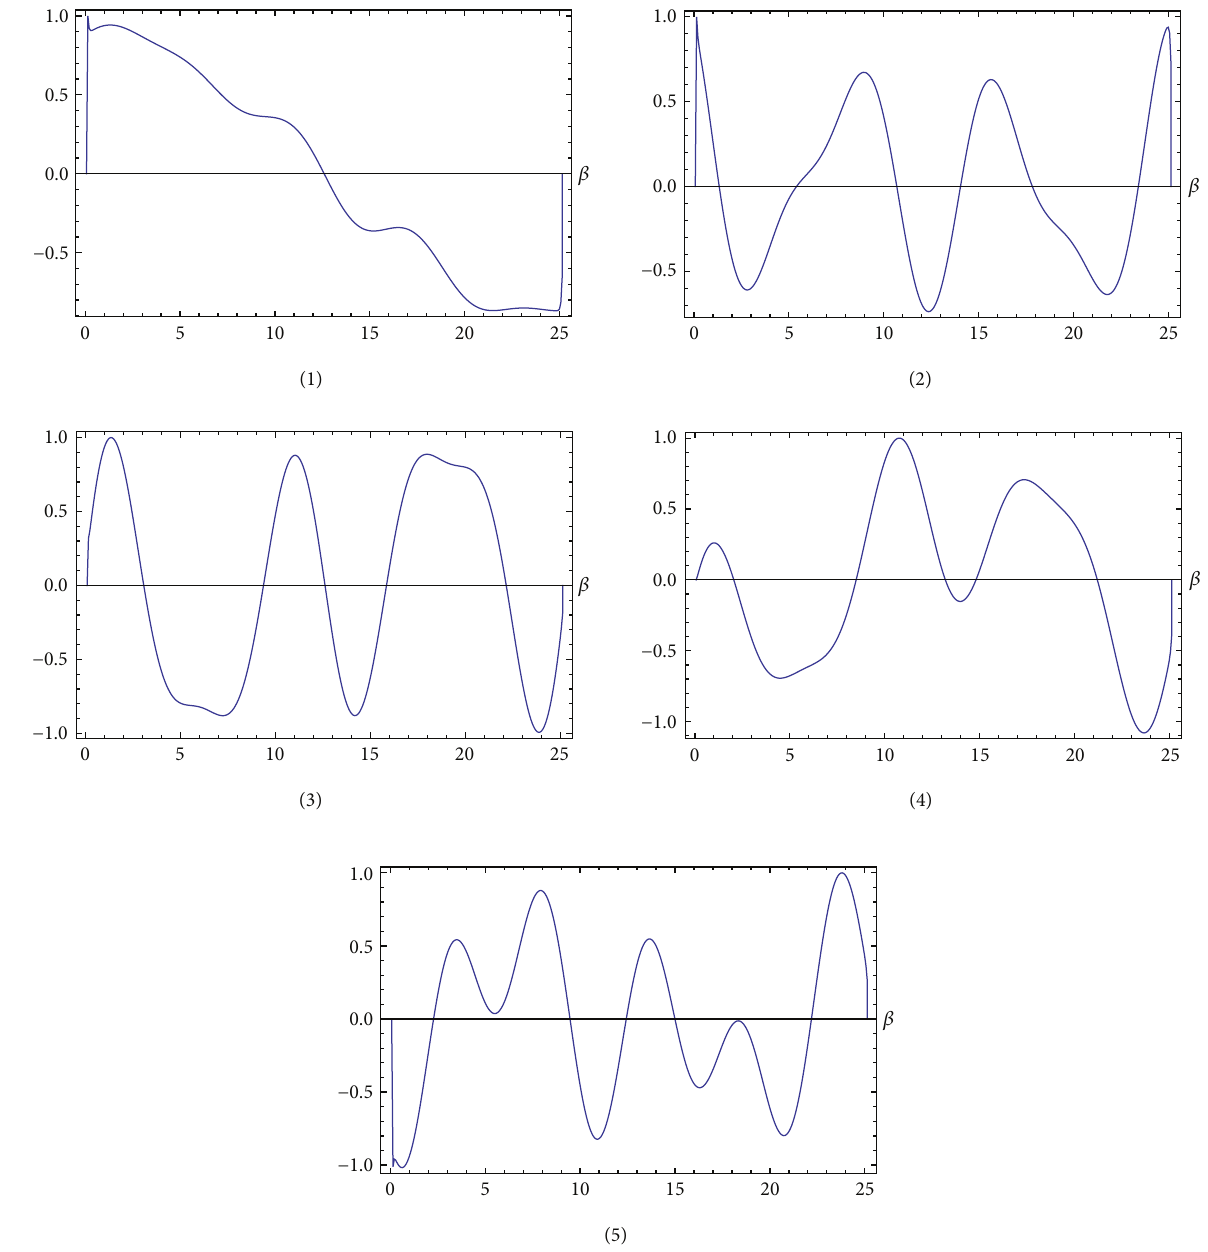
Figure 5: First five normal mode shapes of the generalized warping coordinate of a die spring: (1) first mode (523.25 Hz); (2) second mode (897.71Hz); (3) third mode (914.36 Hz); (4) fourth mode (973.88 Hz); (5) fifth mode